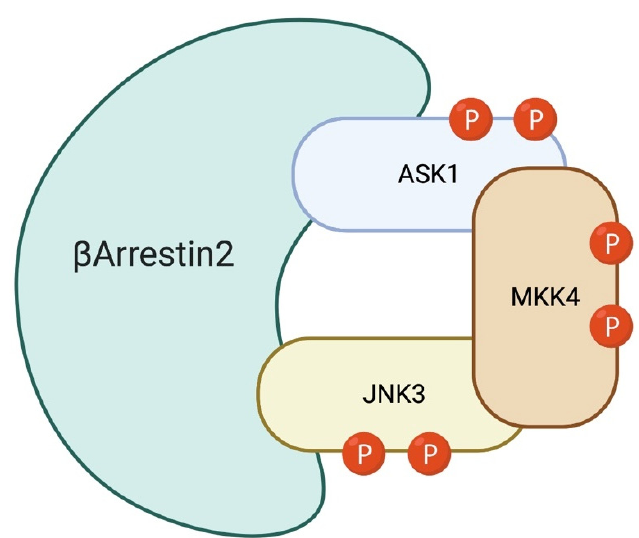
Figure 3. β -Arrestin-2: JNK3 scaffold. β -Arrestin-2 specifically associates with the JNK3, MKK7/4 and ASK1. Inactive-JNK3 binds β -arrestin-2 close to the MKK7/4 bond-site, facilitating full JNK3 activation. P-JNK3 loses its affinity to the scaffold and, by detaching from it, allows the binding of other inactive JNK3.